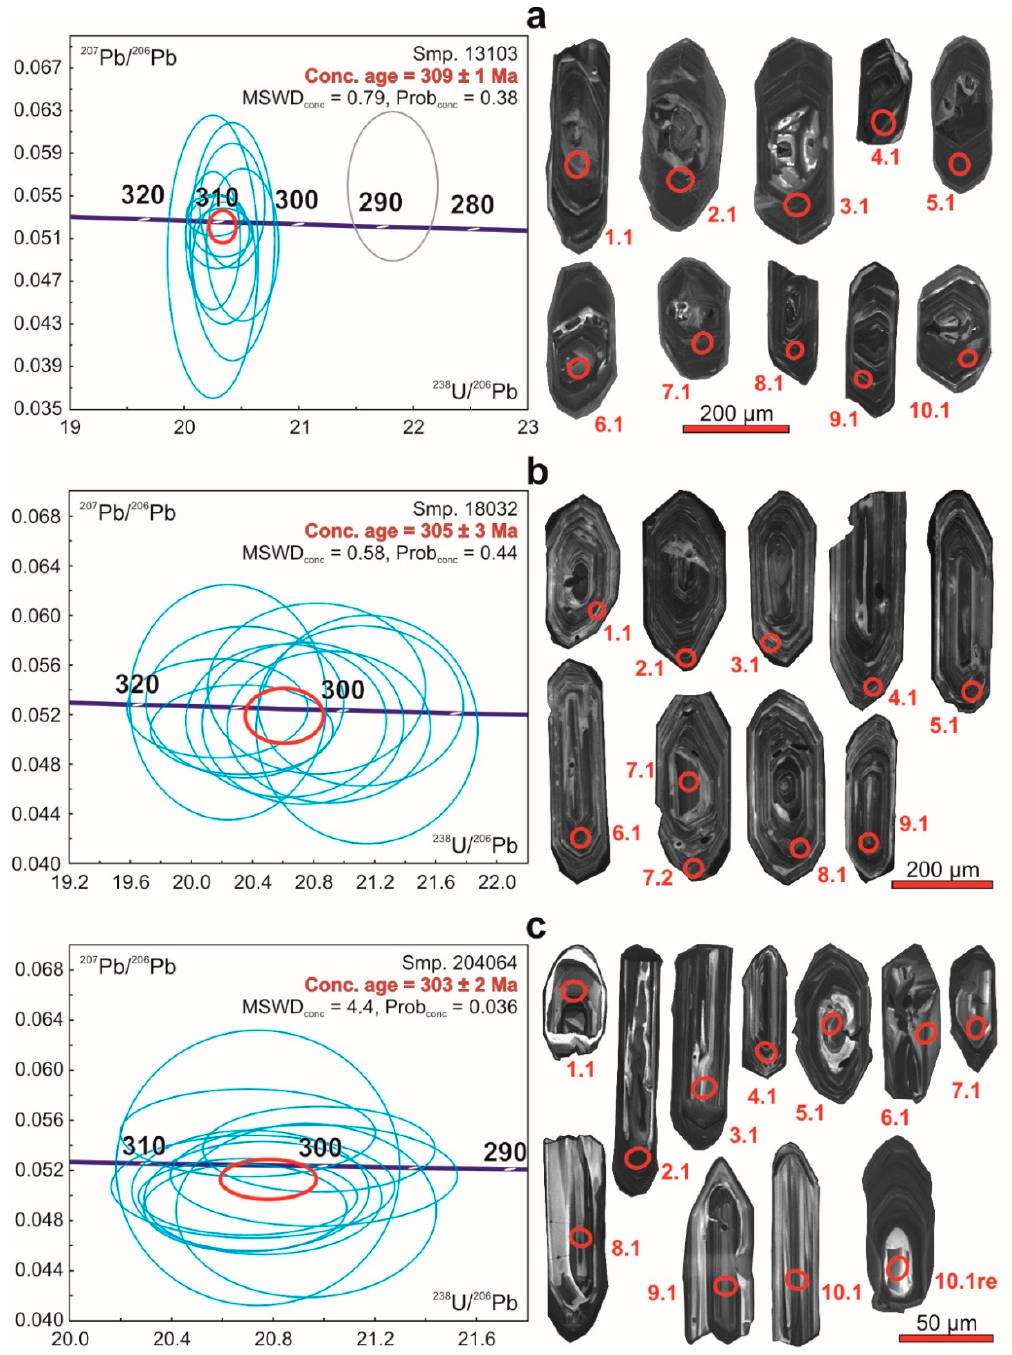
Figure 13. Concordia diagrams and CL zircon images for samples of the first generation of syncollisional granitoids of the Kara orogen: sample 13103 ( a ), sample 18032 ( b ), sample 204064 ( c ). Data-point error ellipses are 2s; decay-const. errs included.